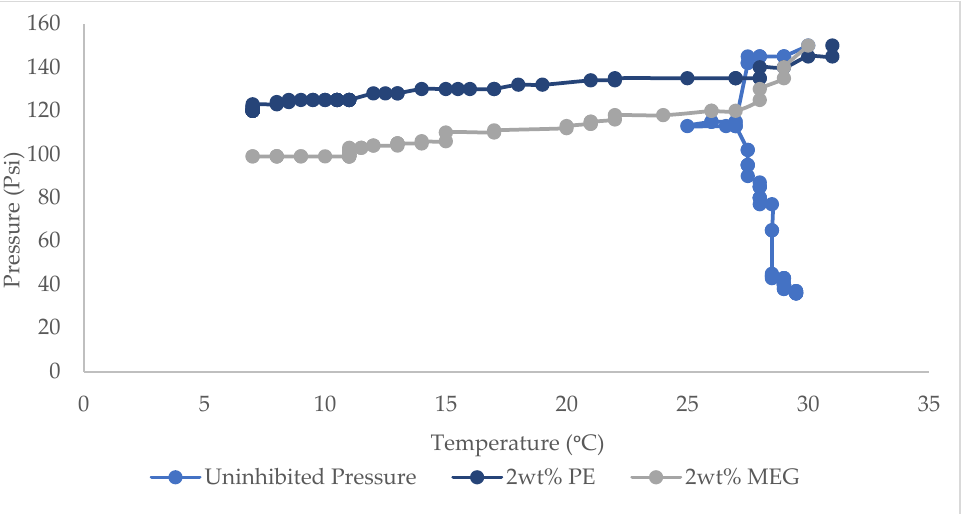
Figure 8. Pressure versus Temperature for 2 wt% Plant Extract (PE), Mono Ethylene Glycol (MEG) and Uninhibited Experiment (water and Gas).